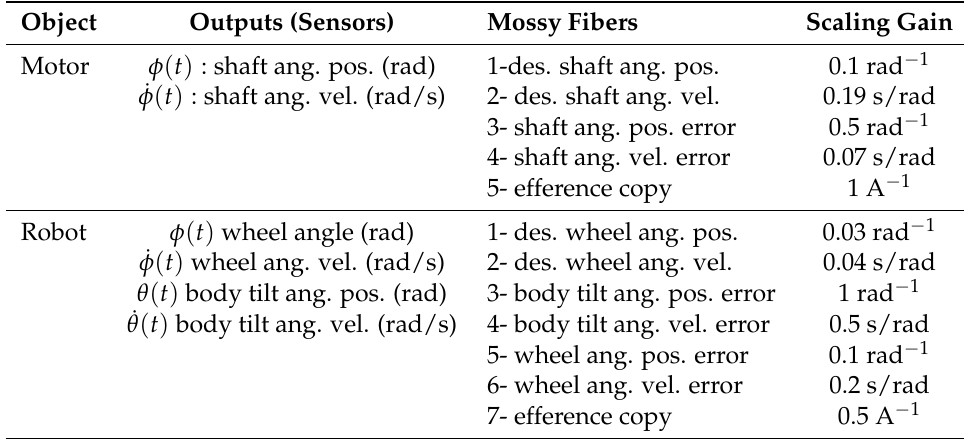
Table 2. Characteristics of the control